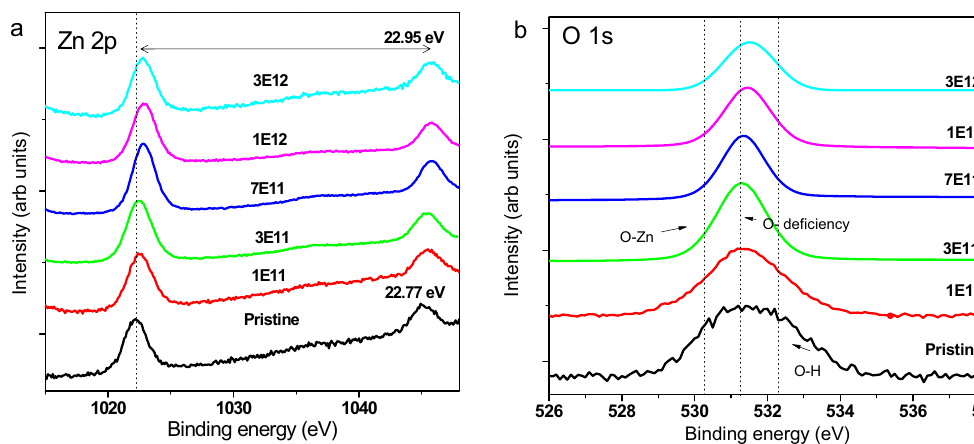
Figure 6. XPS analysis of Ag irradiated ZnO NR arrays in different fluences indicating the presence of structural deformations: ( a ) Zn 2p, and ( b ) O 1s